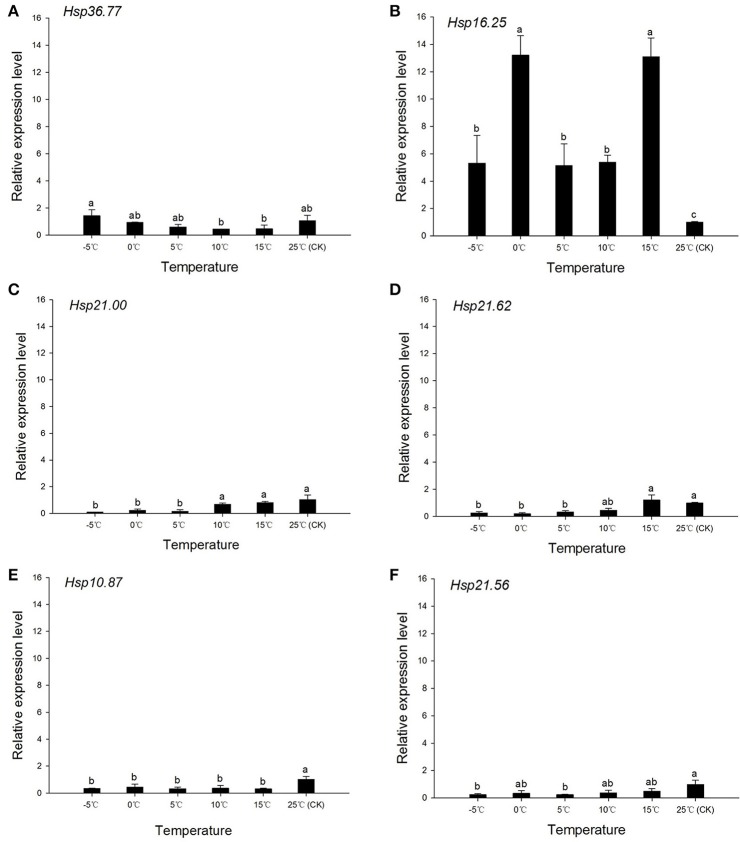
Relative expression of Harmonia axyridis sHSPs under the short-heating treatment. Experimental population is used for this trial. (A)
Hsp36.77. (B)
Hsp16.25. (C)
Hsp21.00. (D)
Hsp21.62. (E)
Hsp10.87. (F)
Hsp21.56. Expression of sHSPs was examined in a gradually heated environment, from −5 to 25°C. During the heating process, the control group (CK) comprised adults reared at an optimum temperature (25°C) without any heat stimulation. Data are presented as means ± s.d. (n = 3). Bars with different letters indicate significant differences (P < 0.05) and used Tukey's test, α = 0.05, a > b > c.